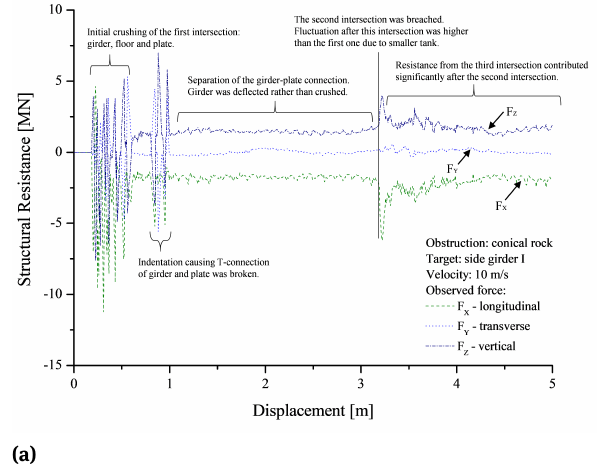
Figure 8: Structural resistance and progressive failure during ship grounding to side